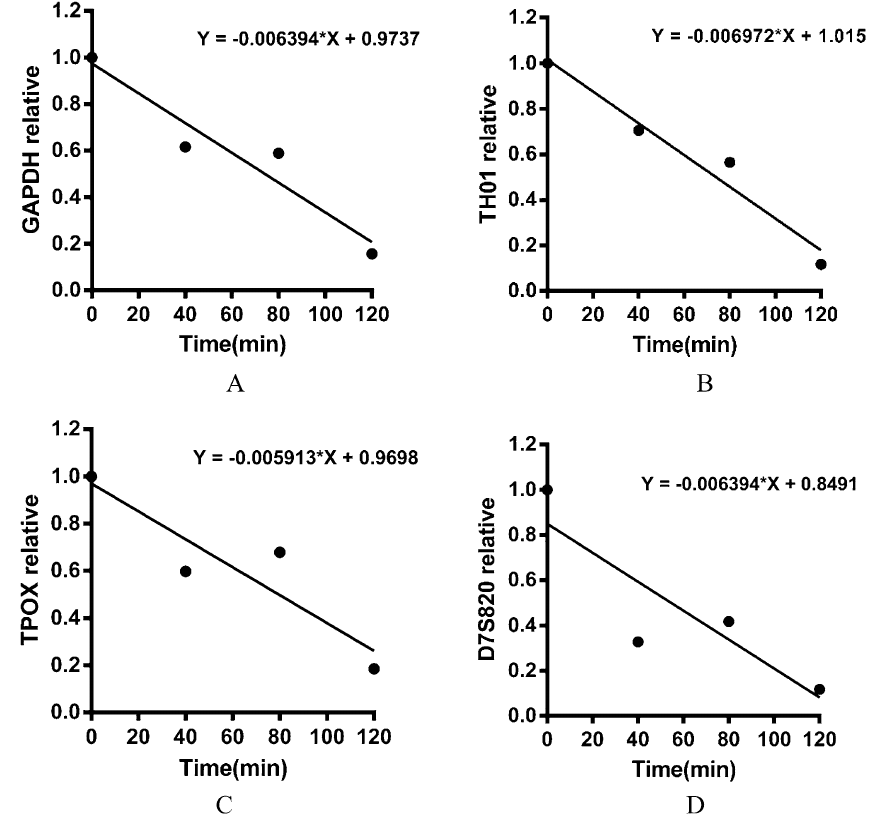
Figure 10. Analysis of the DNA degradation process and rate in the mouse gastrointestinal tract over time, on the basis of qPCR. ( A ), ( B ), ( C ) and ( D ) show the relatively quantitative linear relationship of the DNA of the four target genes with digestion time.